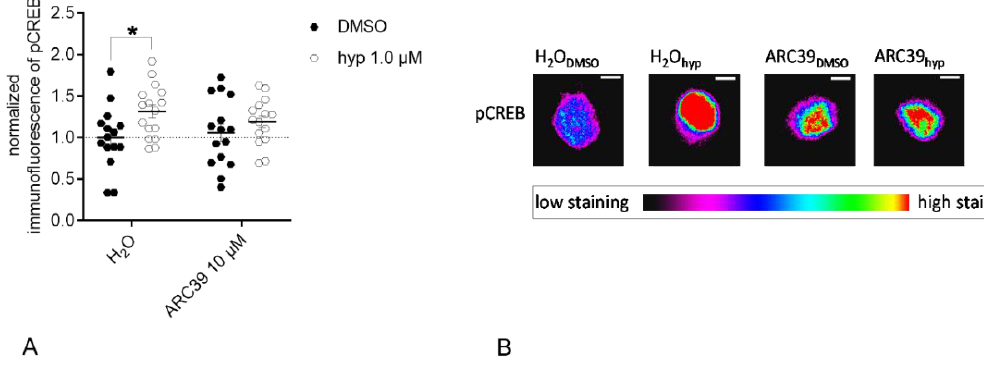
Figure 6. ASM activity inhibition prevents hyperforin-induced CREB phosphorylation in primary rat neuronal cells. ( A ). Hyperforin (1 µ M) induced CREB phosphorylation in rat excitatory cortical neurons after 24 h of treatment. This e ff ect was partly abolished when ASM activity was inhibited with ARC39 10 µ M ( B ). Representative images of pCREB staining in single nuclei of excitatory rat neurons after indicated treatments. Scale bar indicates 5 µ m. Bars indicate mean ± SEM; n = 1 cell batch, 3 cover slips analyzed per batch, 5 regions analyzed per cover slip; * p ≤